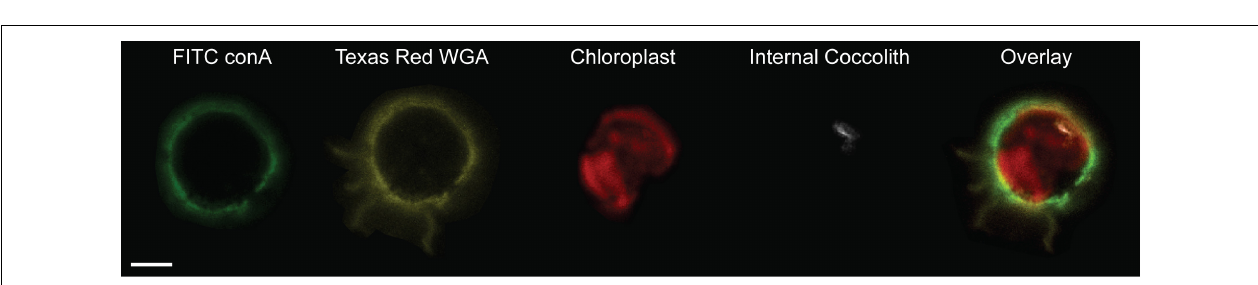
FIGURE 4 | Wheat germ agglutinin (WGA) staining in S. apsteinii. Confocal microscopy imaging of FITC-WGA staining in S. apsteinii . (A) FITC-WGA positively stains lopadoliths, muroliths and an extracellular layer surrounding a fully calcified cell. (B) A discarded murolith. (C) FITC-WGA staining of a decalcified cell reveals a polysaccharide residue that closely resembles the shape of a lopadolith. (D) Transmitted light image corresponding to (C) . Residual polysaccharide from a dissolved lopadolith can be seen (arrowed). Scale bars represent 5 µ m.